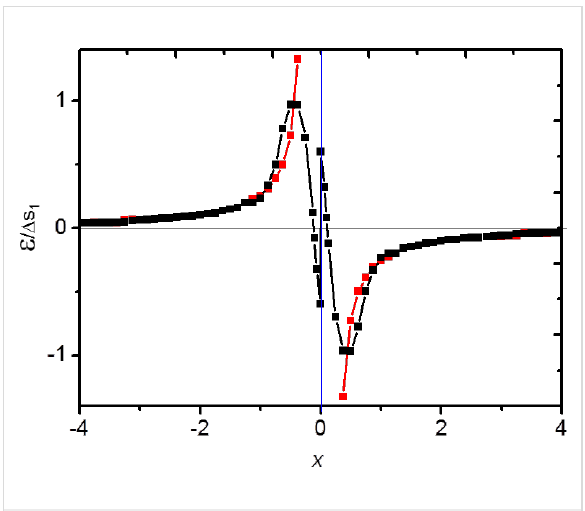
Figure 4: Black squares: normalised strain ε / Δ s 1 solution of Equation 8 calculated for Δ s 1 / S 11 = 0.5, red squares: classical solution plotted from Equation 2. (arbitrary units, vertical blue line corresponds to the location of the ribbons edges sketched in grey in the upper part of the